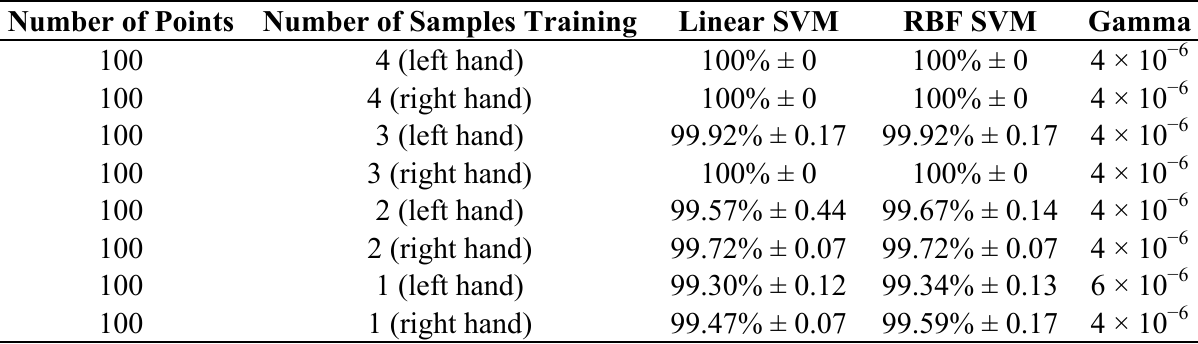
Table 7. Success rates for SVM with 287 UST users for 60 DHMM states and 100 edges coding points, decreasing the training samples.